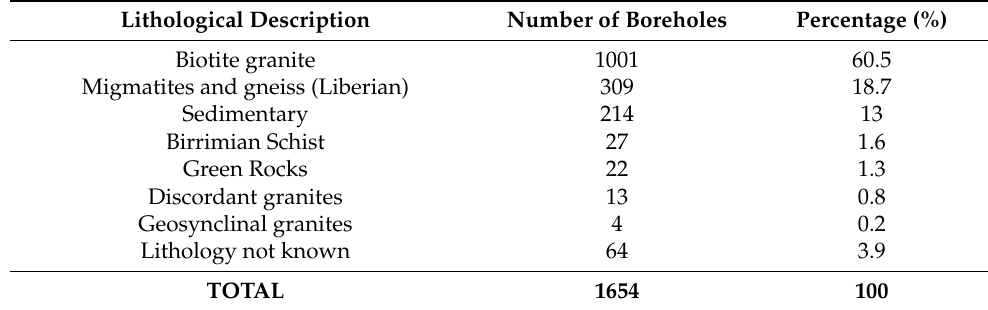
Table 3. Lithologies of boreholes according to the ONEP database (translated from